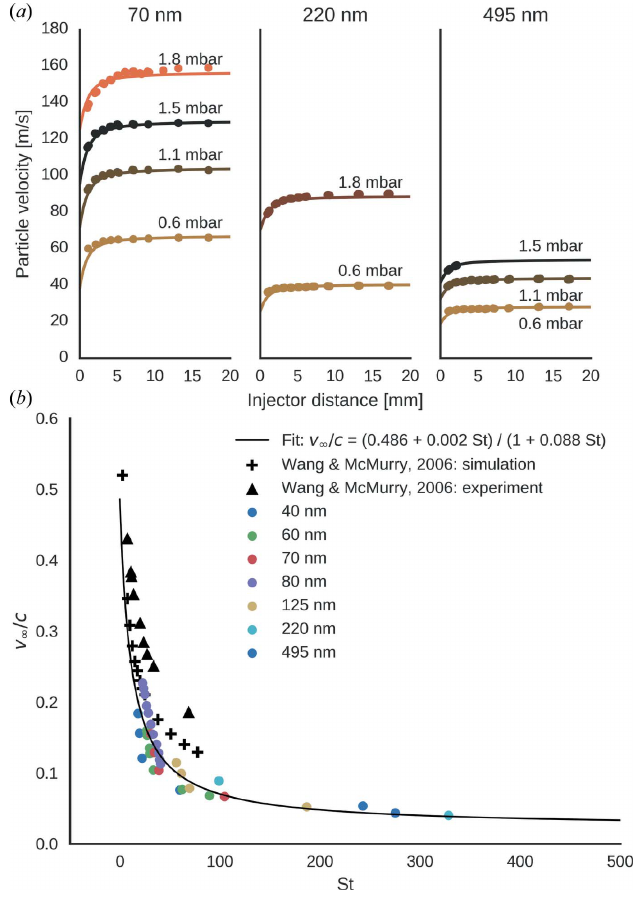
Figure 5 Particle speed and acceleration. ( a ) Particle velocity as a function of their distance from the exit orifice of the injector for polystyrene spheres of 70, 220 and 495 nm in diameter at pressures between 0.6 and 1.8 mbar. The solid lines show the approximated velocity evolution according to our model. ( b ) Terminal-velocity values normalized to the speed of sound plotted against the Stokes number. We compare our data (filled circles) to simulated and experimental data reported by Wang & McMurry (2006) for the same lens system with air as a carrier gas and at higher injector pressures than studied